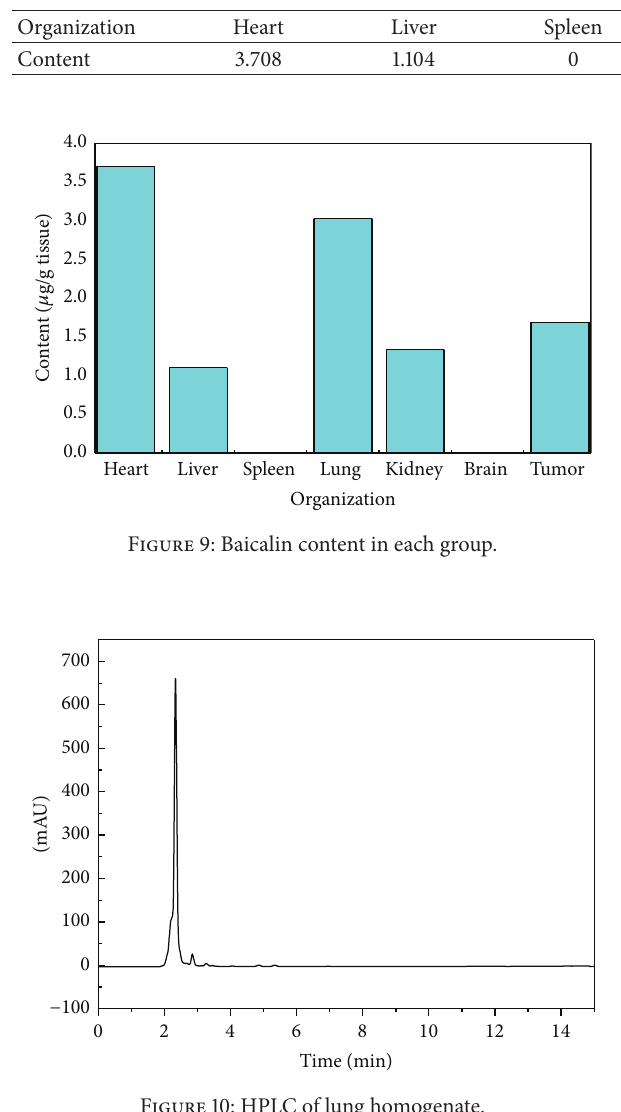
Table 5: U14 cervical cancer organizations mice baicalin.